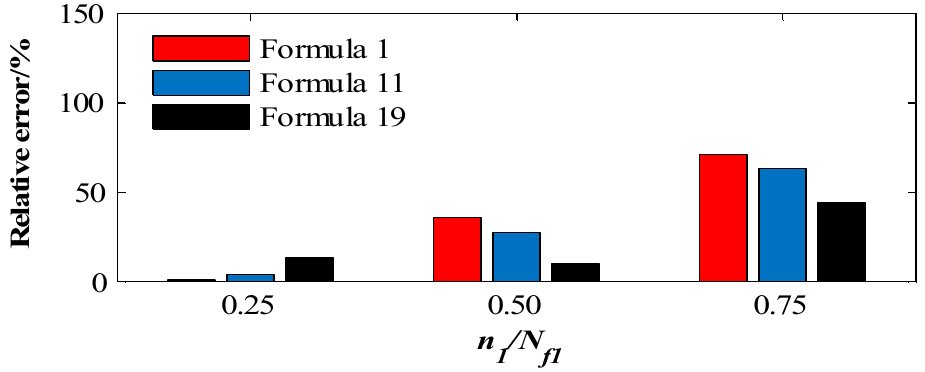
Figure 12. (284.4–331.5 MPa) The relative error of each model under different n 1 /N f 1 (45# steel). It can be seen from Figures 11 and 12, for 45# steel, under high–low load loading, as the proportion of high load continues to increases, the relative error of Miner’s rule in- creases significantly. The relative error fluctuation of the toughness dissipation model is relatively stable, and the overall value is smaller than Miner’s rule. The relative error be- tween the result obtained by the improved model and the actual value is the smallest among these three models. In the case of low–high loading, the error between the results obtained by the three models and the actual value is smaller than the error obtained in the case of high–low loading. Like the results of 18CrNiMo7-6, both reflect that under high–